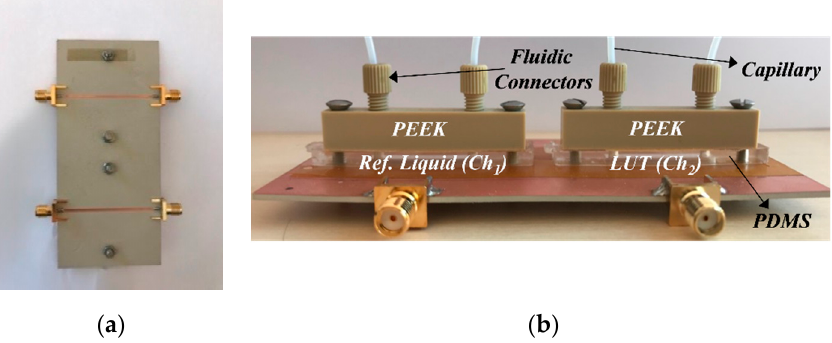
Figure 6. Photographs of the fabricated microwave sensor. The considered materials are indicated. ( a ) Top view ( b ) Lateral view.